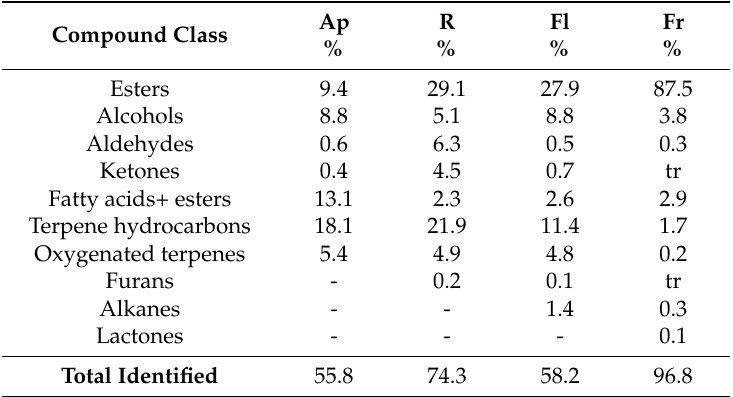
Table 5. Chemical class distribution of the samples.